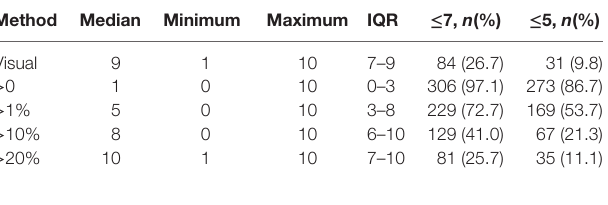
TaBle 2 | Median, minimum, maximum, interquartile range of Alberta Stroke Program Early Computed Tomography Score, number of patients below ≤ 7, and ≤ 5 thresholds values using different rating